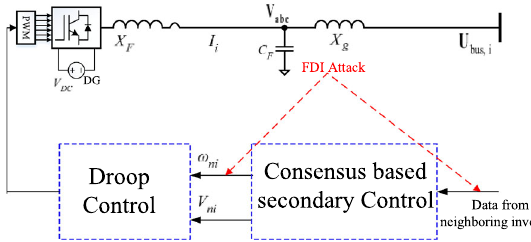
Fig. 8 Illustrative diagram of consensus-based control of inverter i under FDI